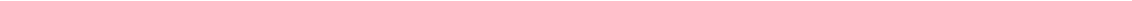
Fig. 6 Validation of Zic1 as a marker for the right eye-enriched RGC subtype 34. a Average expression of Zic1 is higher in the right eye RGCs compared to the left eye RGCs (mean ± SEM shown; independent samples t -test, * p < 0.0001). b Average expression of Zic1 per RGC is similar between right and left eye RGCs in cluster 34, which is enriched for Zic1 (mean ± SEM shown; arrow indicates subtype 34). c , d Percent of RGCs per cluster that express Zic1 is shown relative to the total RGCs in the left (red) or right (blue) eye. Arrow indicates subtype 34 in which Zic1 is expressed in almost twice as many right eye RGCs compared to the left eye ( c ), consistent with the percent of right eye RGCs in subtype 34 being almost twice higher compared to left eye RGCs, relative to the total RGCs in each eye ( d ). e , f Representative images of retinal cross-sections ganglion cell layer (GCL) from the left ( e ) and right ( f ) eyes of mature mice, immunostained as marked for an RGC marker RBPMS, nuclear marker DAPI, and Zic1. Enlarged examples of Zic1 + /RBPMS + /DAPI + RGCs from regions outlined in dashed line box are shown in insets on the sides, demonstrate that Zic1 signal colocalizes with DAPI in the nucleus, as expected for a TF. An example of Zic1 + /RBPMS − /DAPI + (possibly displaced amacrine) cells in the GCL is outlined in dashed line oval ( e ). Scale bars as marked. g Quanti fi cations of Zic1 + /RBPMS + RGCs as percent of total RGCs in different retinal regions show signi fi cant enrichment of Zic1 + RGCs in the right eye overall and in the ventrotemporomedial retinal regions in both eyes (mean ± SEM shown; * p < 0.05, ** p < 0.01 by ANOVA with post hoc LSD pairwise comparisons; N = 4 for left and right eye each, with different retinal regions quanti fi ed from each eye, shown as dots plot overlaying the bars, as detailed in the